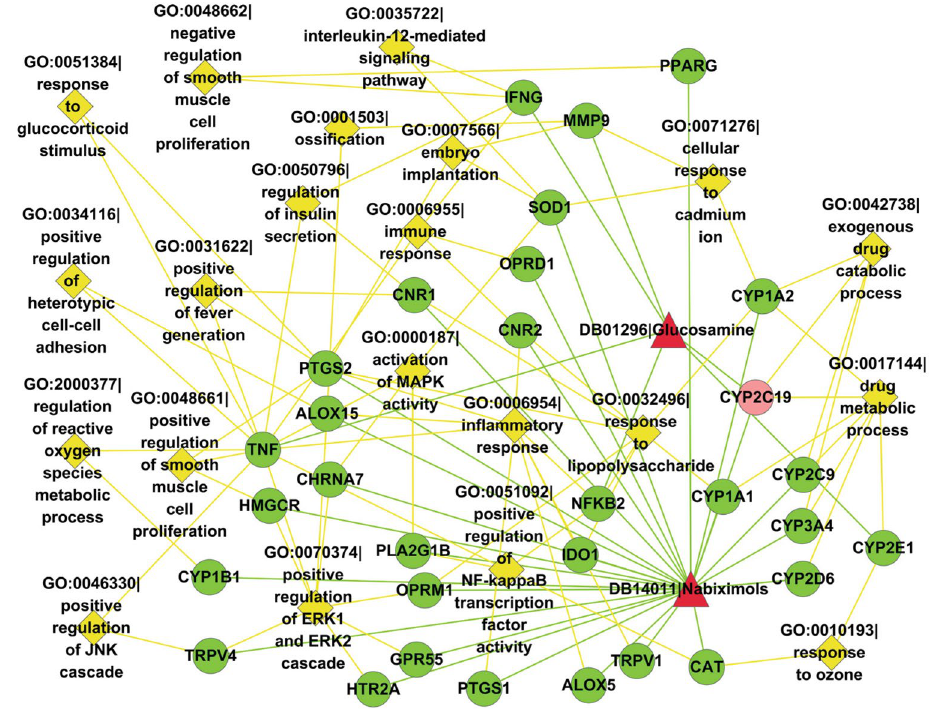
Figure 5. Common cellular processes of target genes between DB14011|Nabiximols and DB01296|Glucosamine predicted to interact. Red triangle nodes denote drugs; green circle nodes denote drug target genes; light red circle nodes denote common target genes; and yellow diamond nodes denote biological processes of gene ontology. This drawing is created by Cytoscape version 2.8.2 (https:// cytos cape.